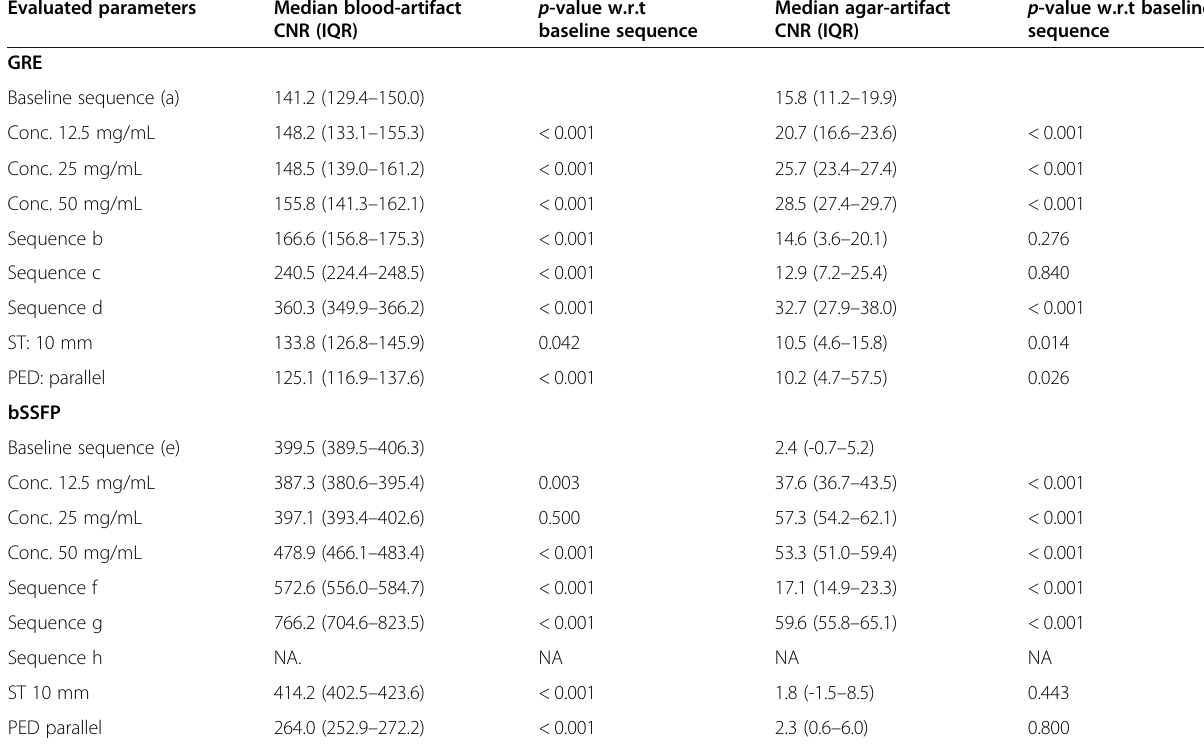
Table 2 Contrast-to-noise ratios for all evaluated parameters Evaluated